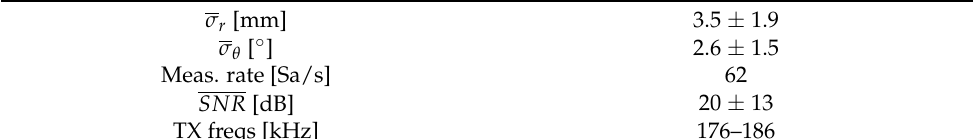
Table 1. Summary of the main features of the MPS.